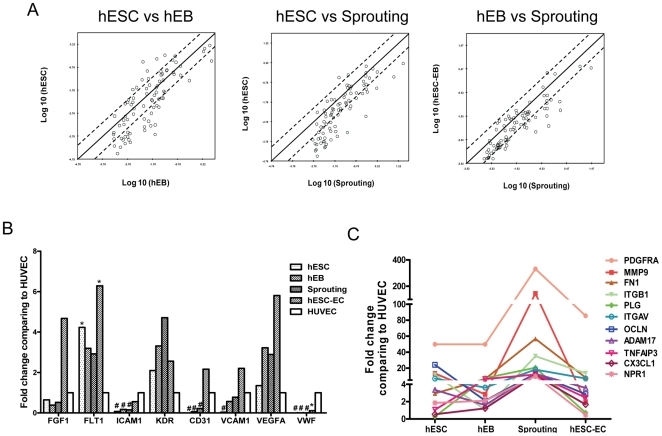
Quantitative PCR confirmation of endothelial gene expression in hESC, EB, EB sprouting, hESC-EC, and HUVEC.(A) Scatter plots of the endothelial related gene-expression were compared between hESC vs EB, hESC vs EB sprouting, and EB vs sprouting. Endothelial related genes expression was analyzed by Human Endothelial Cell Biology RT2 Profiler PCR Array. The array includes 84 genes related to endothelial cell biology. The lines indicate the diagonal and 4-fold changes between the two samples. (B) Kinetic expression of selected endothelial genes among hESC, hEB, hEB sprouting, hESC-EC, and HUVEC. Compared to HUVEC, hESC-ECs express abundant endothelial gene except adult endothelial gene vWF. *P<0.05; #P<0.01 compared with HUVECs. (C) After EB embedded into collagen, endothelial differentiation was triggered. Note endothelial activation related gene expression increased swiftly regardless of the level at the beginning.